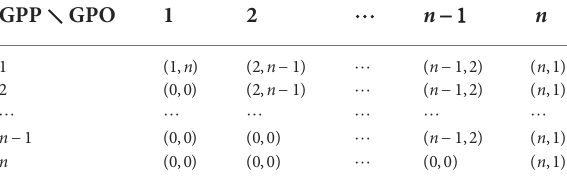
TABLE 1 Payoff bi-matrix. GPP ⟍